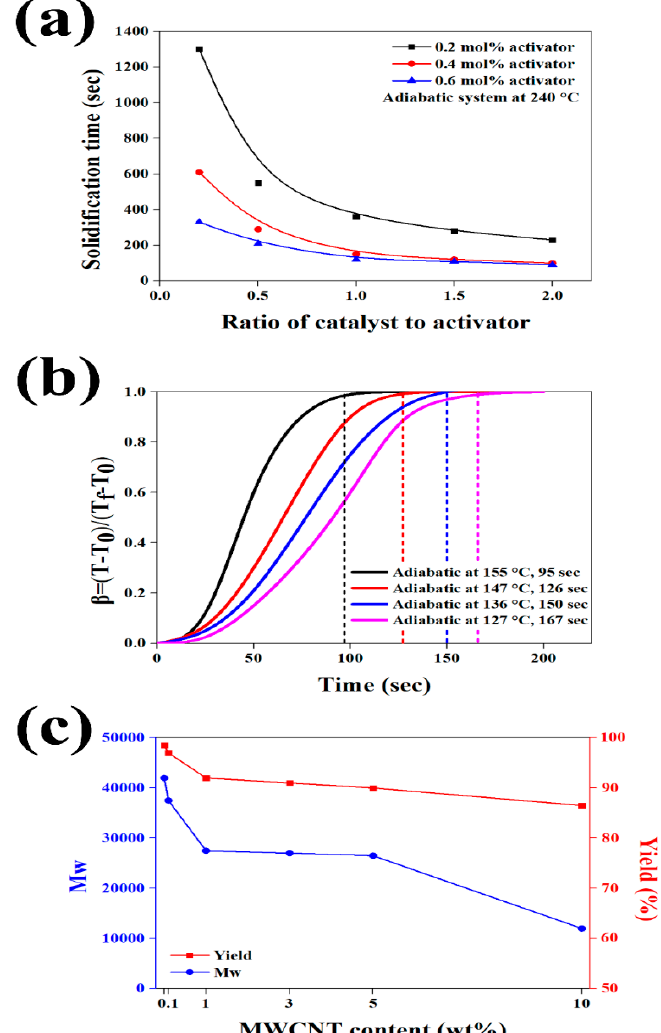
Figure 4. ( a ) Dependence of solidification time on the catalyst to activator ratio at 240 °C, ( b ) reaction kinetics expressions of Wittmer and Gerrens, and ( c ) molecular weight and yield of polymerized PA6 according to MWCNT content.